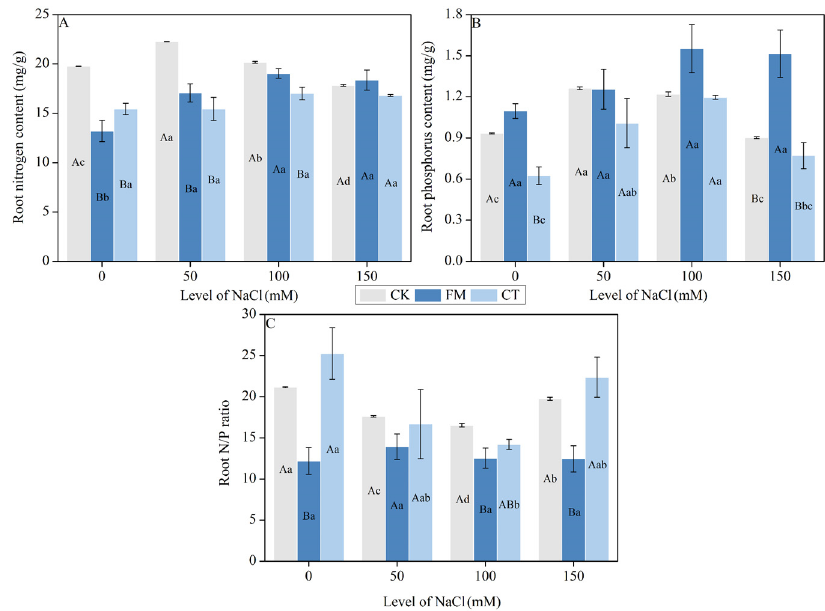
Figure 3. Variations in root nitrogen, phosphorus content, and N/P ratios between treatments. ( A ) root nitrogen content of different treatments; ( B ) root phosphorus content of different treatments; ( C ) root N/P ratio of different treatments. Letter and error bar meanings are consistent with Figure